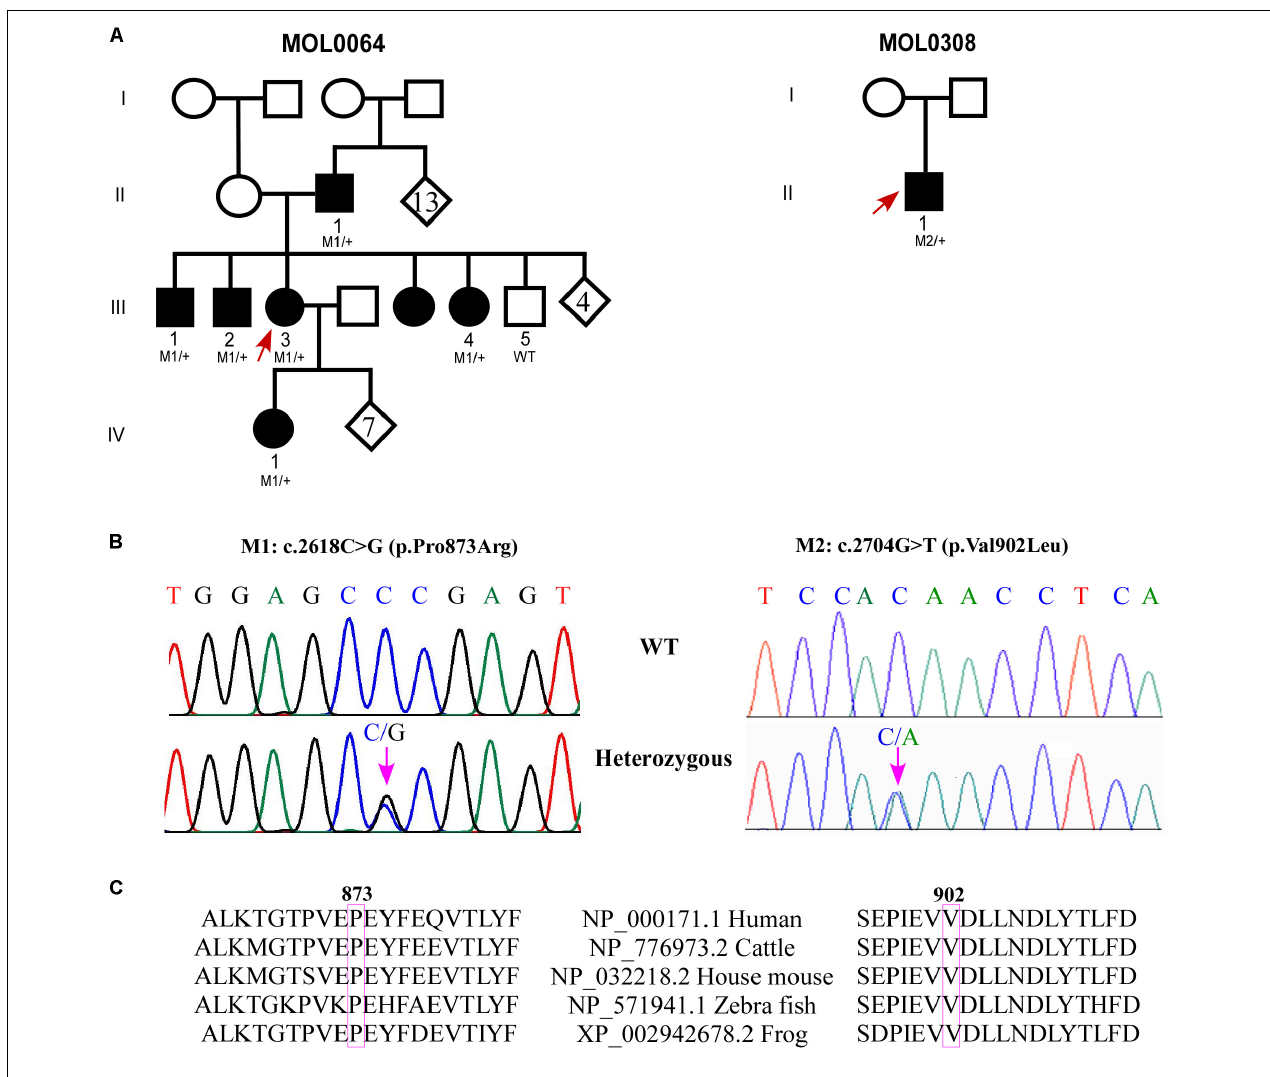
FIGURE 1 | Genetic analysis of families with GUCY2D variants. (A) Pedigrees of MOL0064 and MOL0380. Affected individuals are marked with a filled symbol. Index cases are marked by arrows. When available, the genotype is depicted below the individual symbol. (B) Chromatograms of novel missense variants in GUCY2D . (C) Sequence alignment of GUCY2D proteins in the variants